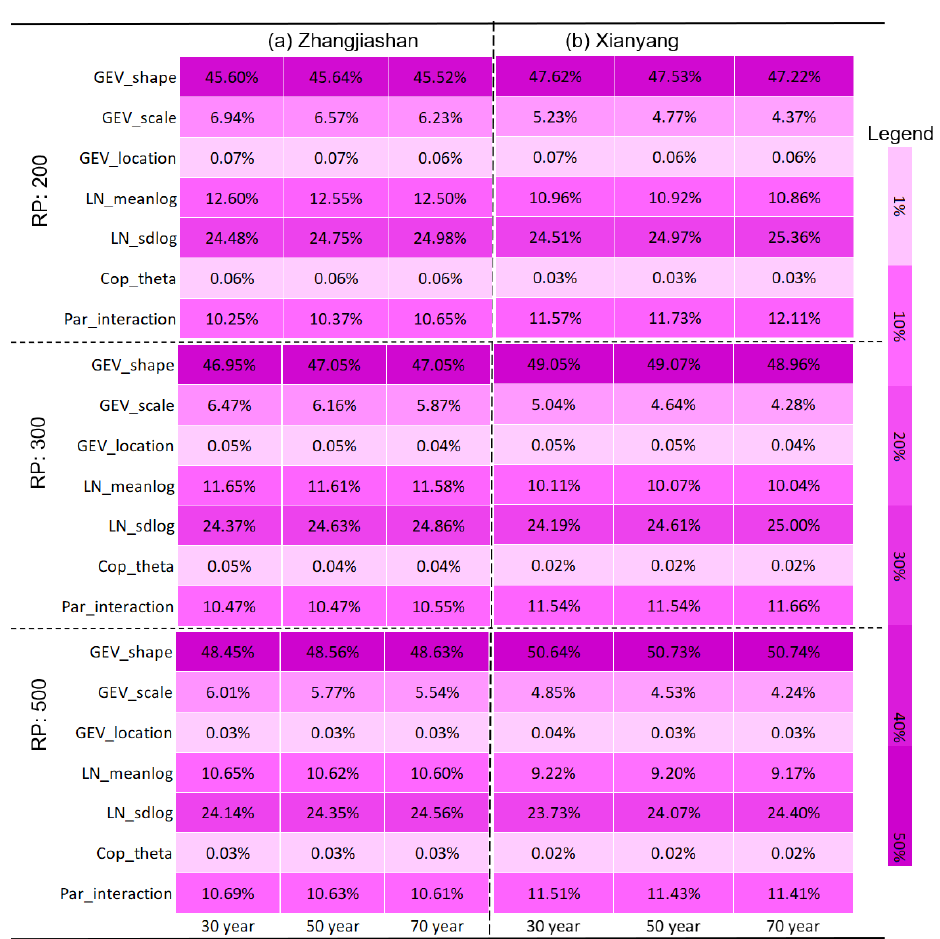
Table 9. Contributions of parameter uncertainties to predictive failure probabilities in Kendall under different design standards (i.e. return periods – RPs) and different service